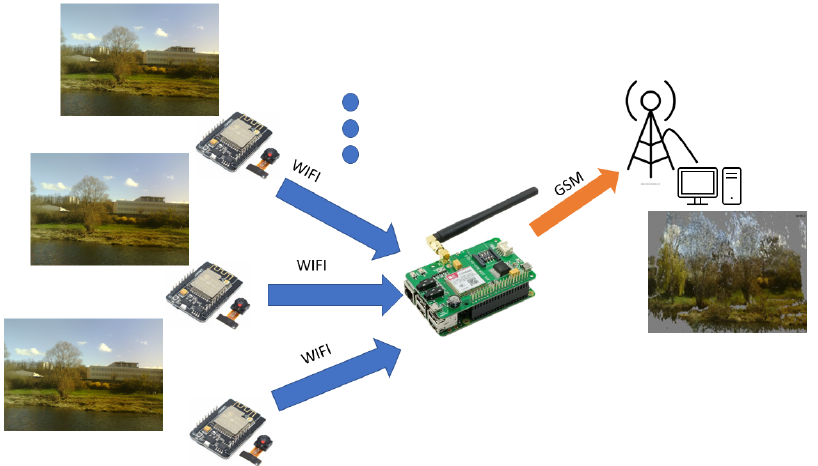
Figure 6. Description of the sensors network. Each image sensor communicates using Wi-Fi to the relay which transmits the images by GSM to the processing